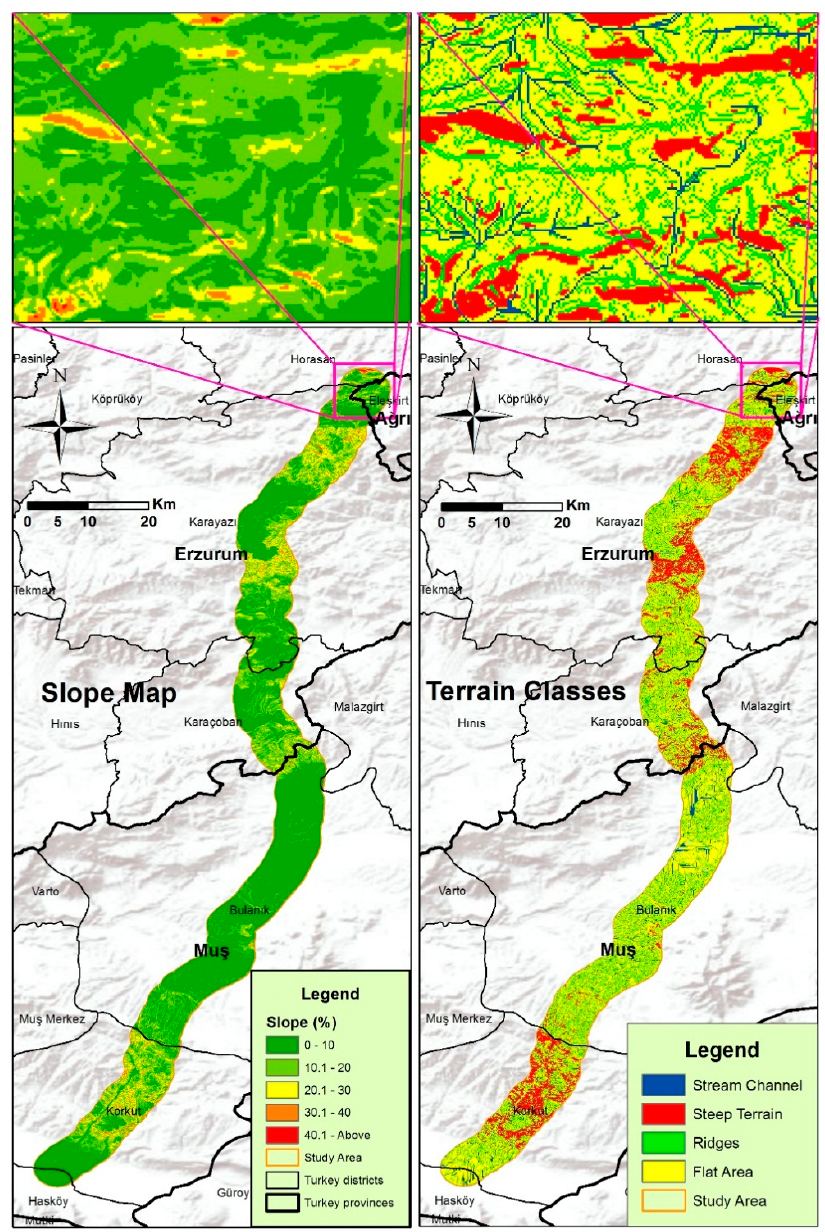
Figure 6. The results of slope map and terrain classification.